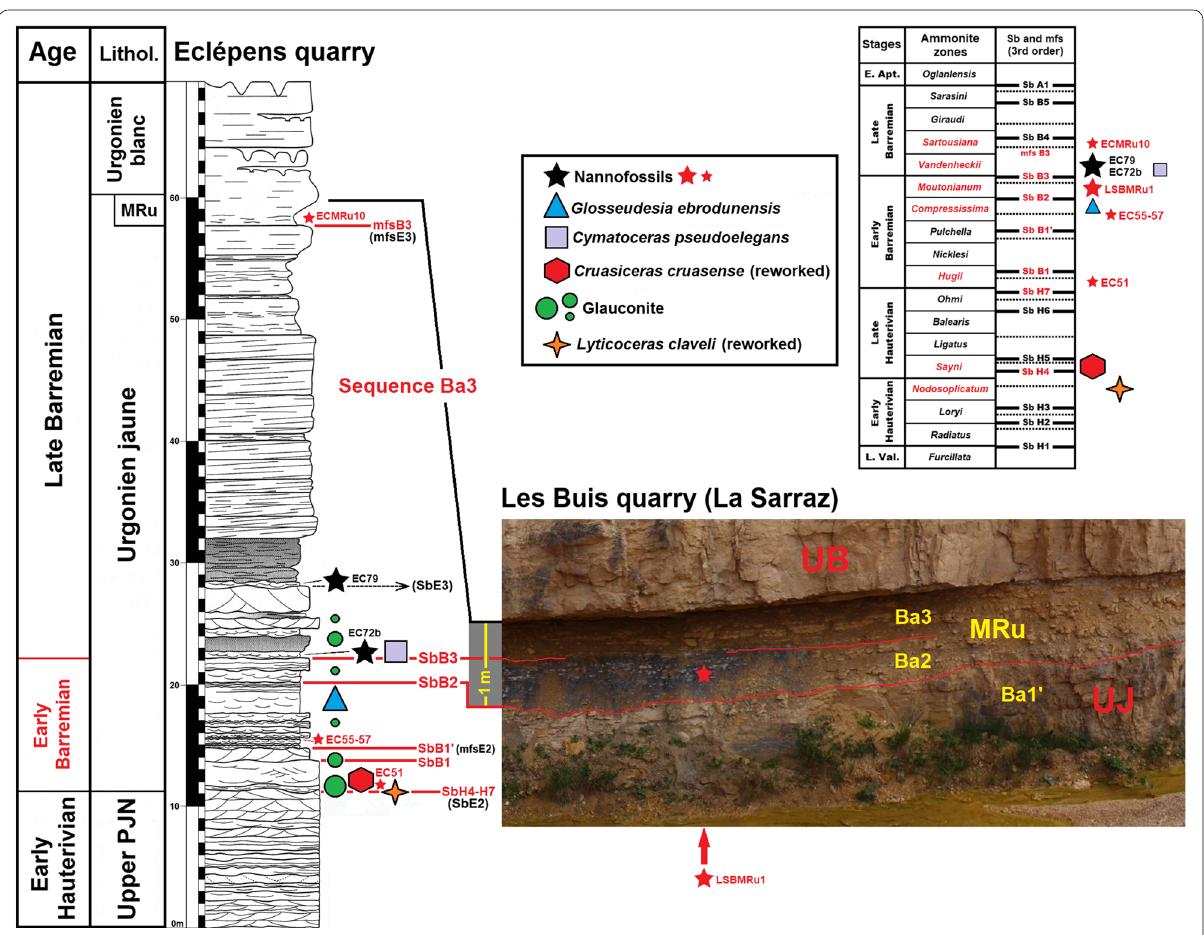
Fig. 3 Part of the Eclépens quarry section log (non‑coloured reference log and data reported from Blanc‑Alétru 1995; Godet et al. 2010 Adatte et al. 2005, 2015) with new biostratigraphical and sequential data of this study indicated by coloured elements (cf. Fig. 2), compared to the section of La Sarraz–Les Buis quarry (cf. Fig. 1c) with early Late Hauterivian–early Late Barremian 3rd order sequences Ha4 to Ba3 (delimited in red) and new late Early Barremian nannoflora of the Tethyan NC5D and Boreal LK19 biozones reported in this study (LSBMRu1 sample = red star). Captions: UB = Urgonien Blanc, MRu = Marnes de la Russille, UJ = Urgonien Jaune. The table (upside right) with latest Valanginian to Early Aptian Tethyan ammonite biozones and 3rd sequences is adapted/modified from Arnaud (2005) according to Reboulet et al.